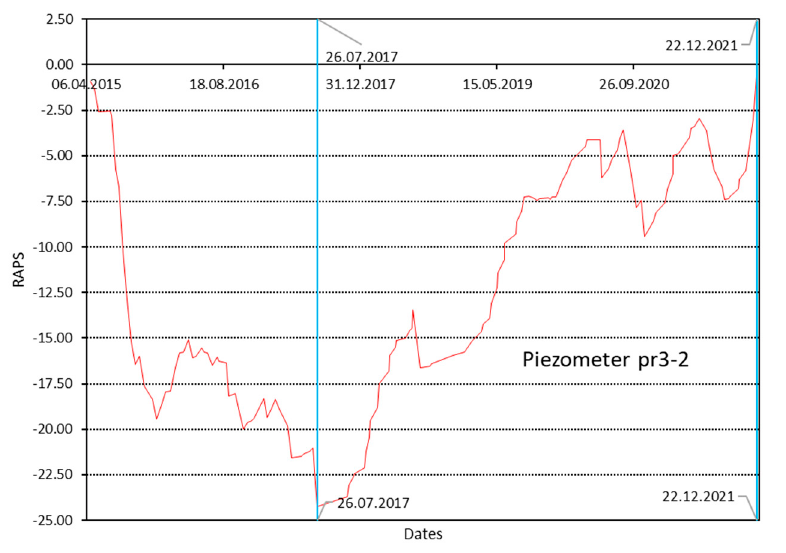
Figure 14. RAPS values for piezometer PR3/2.